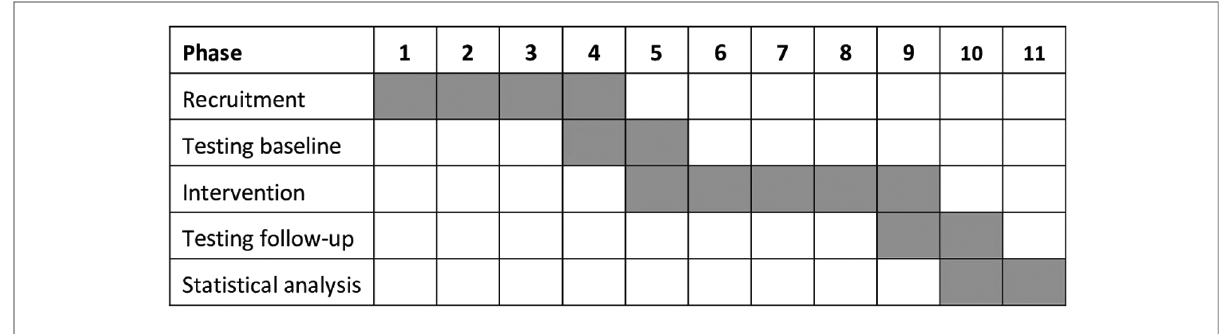
FIGURE 1 Timeline of the project (in months: fi rst patient fi rst – last out).